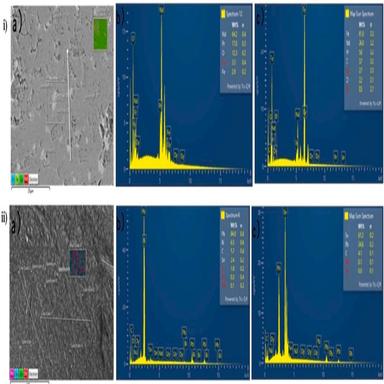
i) EDS results of the magnet sample-a) showing the selected area on the SEM image b) composition for the square area selected c) composition for the point selected- 3ii) EDS results of the solder joint specimen – a) showing the selected area on the SEM image b) composition for the line data 1c) composition for the line data 2.